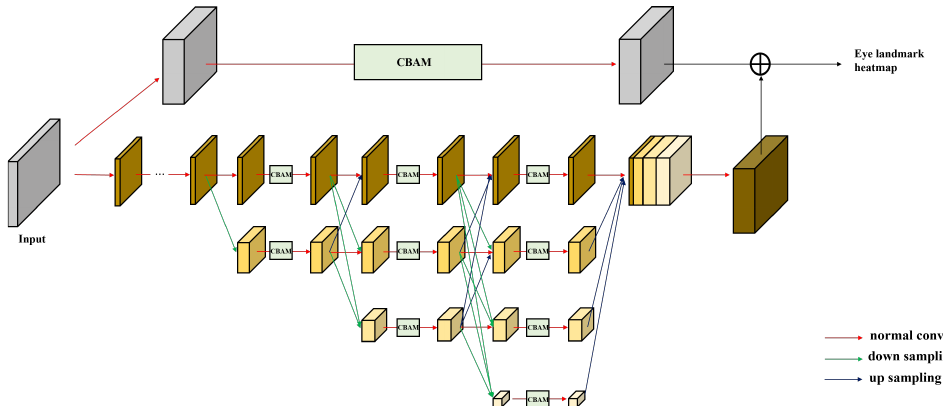
Figure 3. Our landmark-detection network architecture used to extract feature